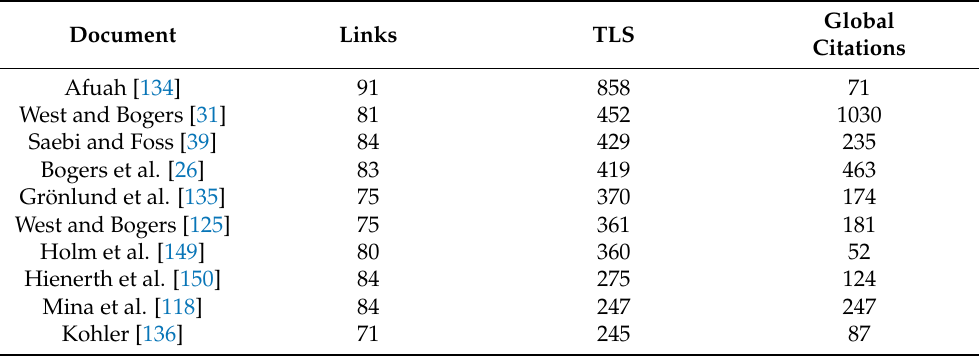
Table A7. Structural bibliometric indicators for the top ten documents included in the bibliographic coupling network (ranked by